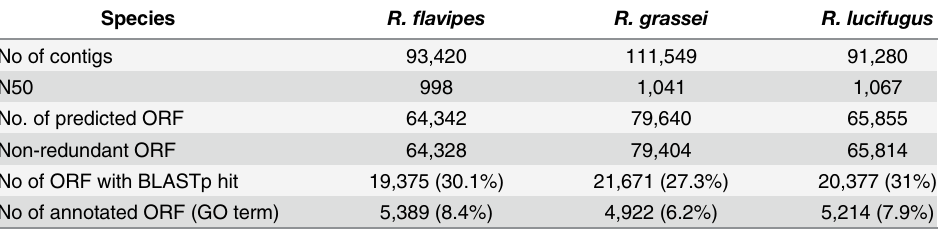
Table 2. Assemblies of transcriptomes, ORF predictions and functional annotations for interspecific comparisons and Gene Ontology analyses. Contigs < 100 bases were removed from